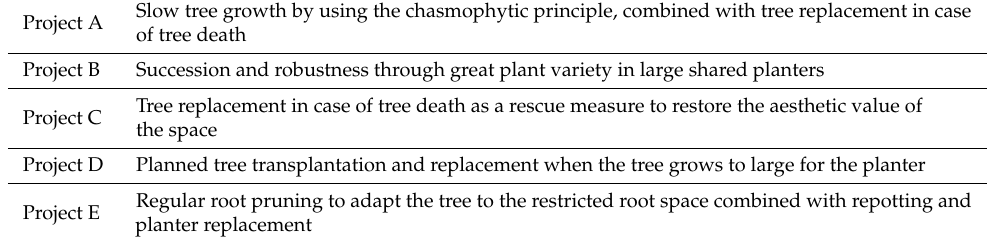
Table 1. Identified design approaches of the five analysed